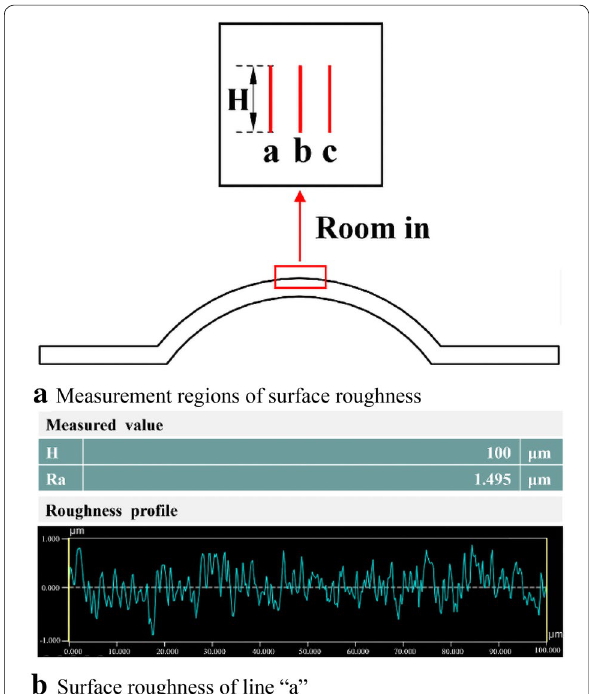
Figure 11 Measurement of surface roughness for bulging part